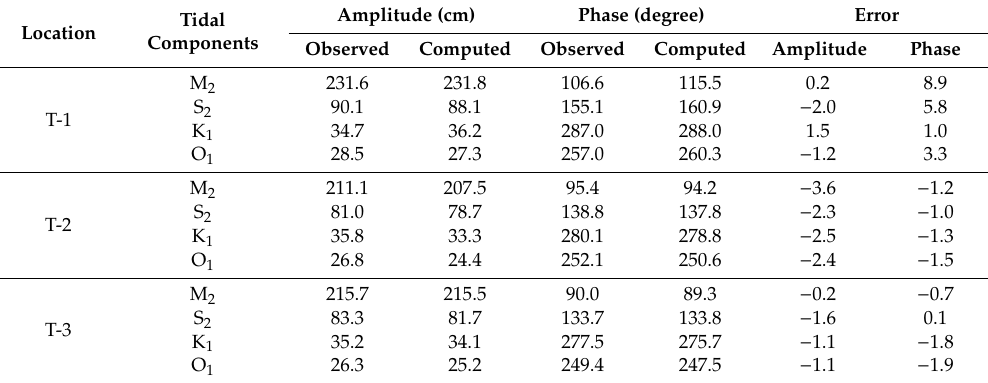
Figure 9. Comparison between observed and computed tidal current time series at ( a ) C-1 and ( b ) C-2. Table 1. Comparison of observed and computed tidal elevation harmonic constants for M 2 , S 2 , K 1 , and O 1 at T-1–3.